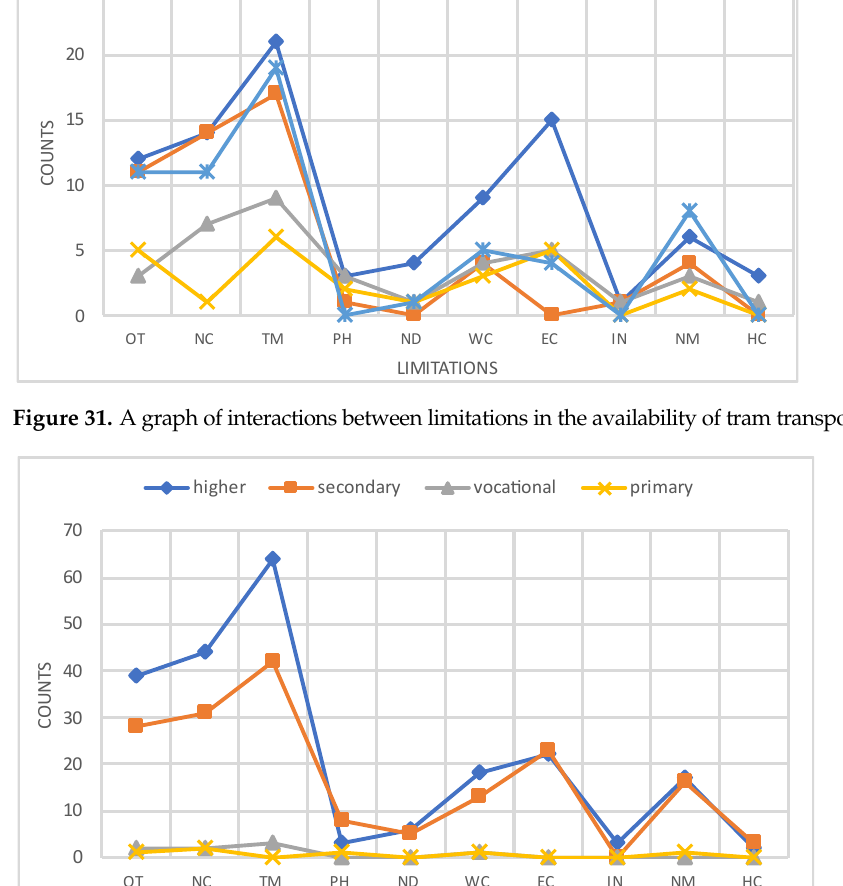
Figure 31. A graph of interactions between limitations in the availability of tram transport and in- dustry.